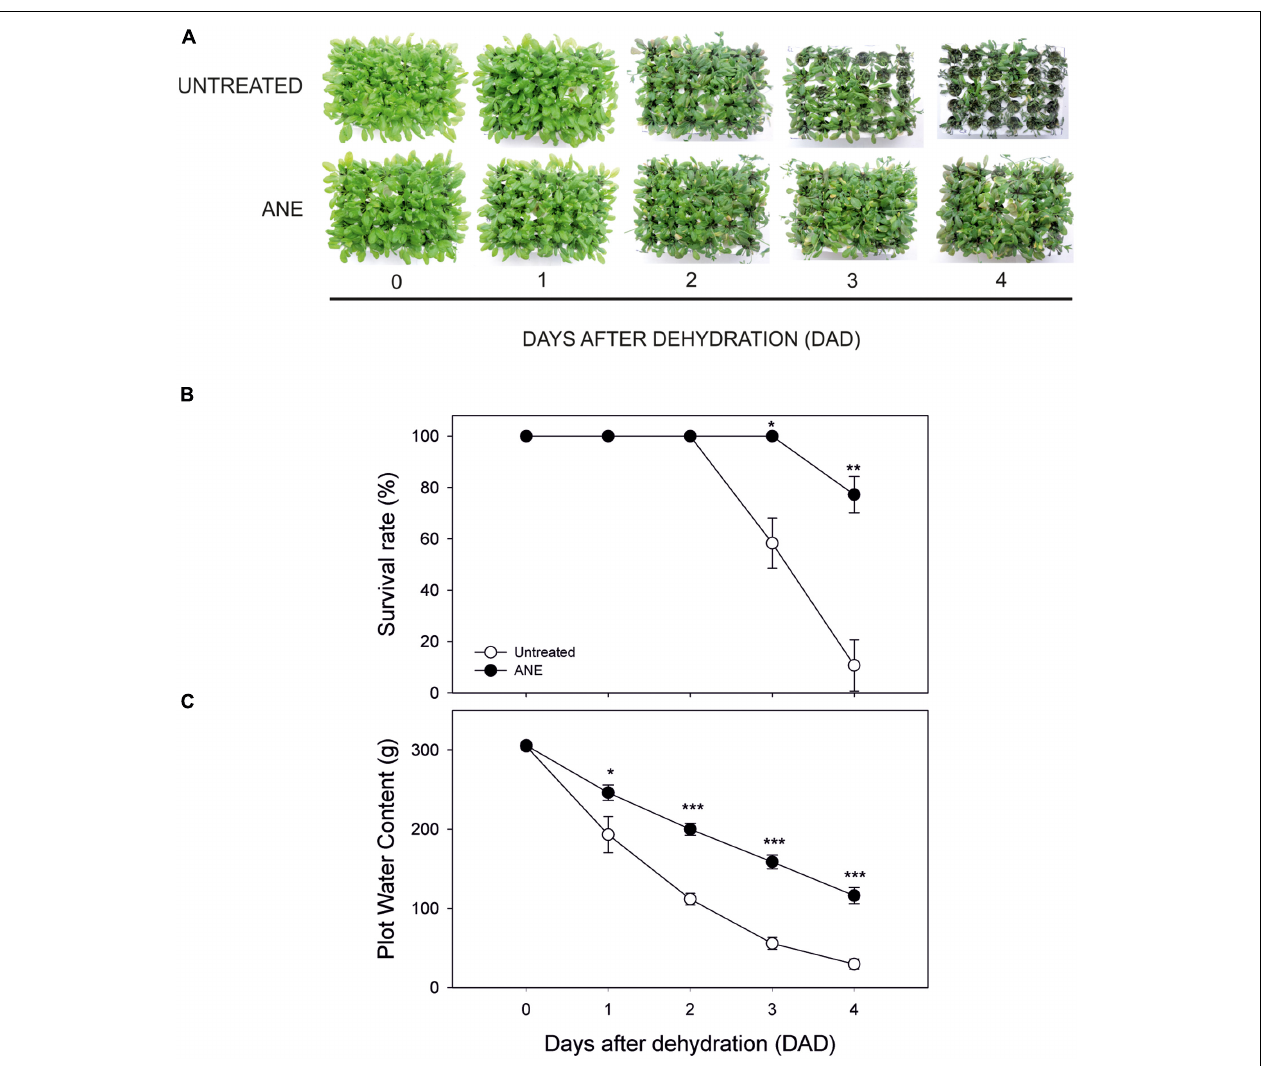
FIGURE 1 | Phenotypical dehydration stress tolerance test, during 4 days of dehydration. Time 0 is the dehydration stress starting time and it corresponds exactly with the last day of Ascophyllum nodosum extract (ANE) treatment. Pictures of treated and not treated plants during 4 days after dehydration (0–4 DAD) (A) , plant survival rate (B) determined as mean ± SE of dead plants on three independent plots for both untreated and ANE-treated ones. Plot water content (C) was measured weighing three independent plots for both untreated and ANE-treated ones (see Materials and Methods). Untreated (white dot) and ANE-treated (black dot) samples were analyzed by one-way ANOVA ( P < 0.05), ∗ P ≤ 0.05; ∗∗ P ≤ 0.01; ∗∗∗ P ≤